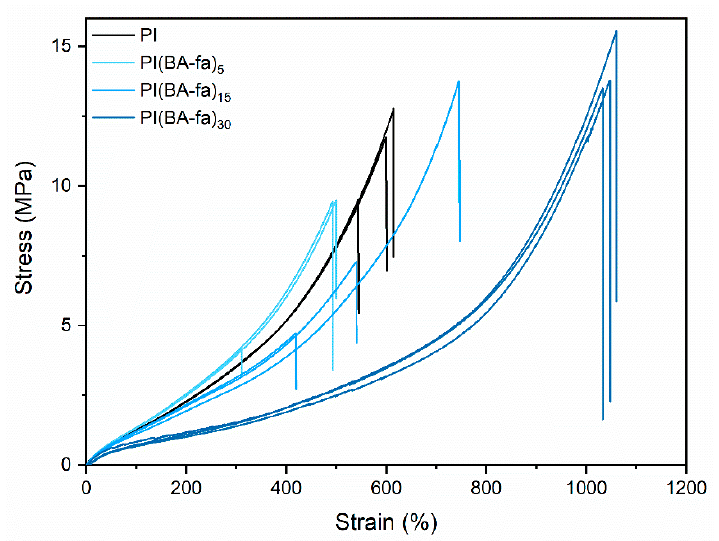
Figure A35. FTIR spectrum of BA-fa.